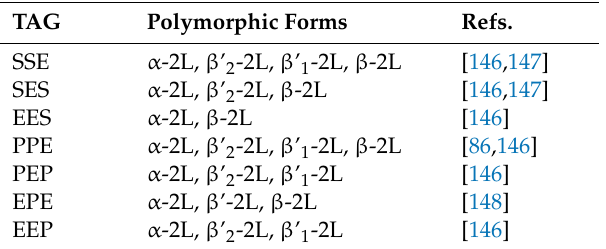
Table 6. Polymorphic forms in elaidic acid-based saturated- trans -unsaturated mixed-acid TAGs. TAG Polymorphic Forms